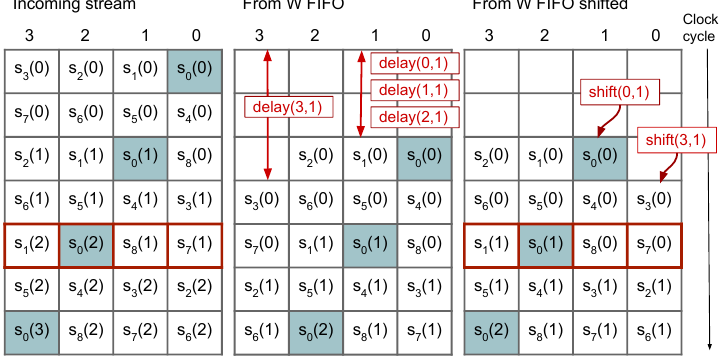
Figure 5. Sample delay operation for obtaining W neighbor samples for N p = 4 and N z = 9.